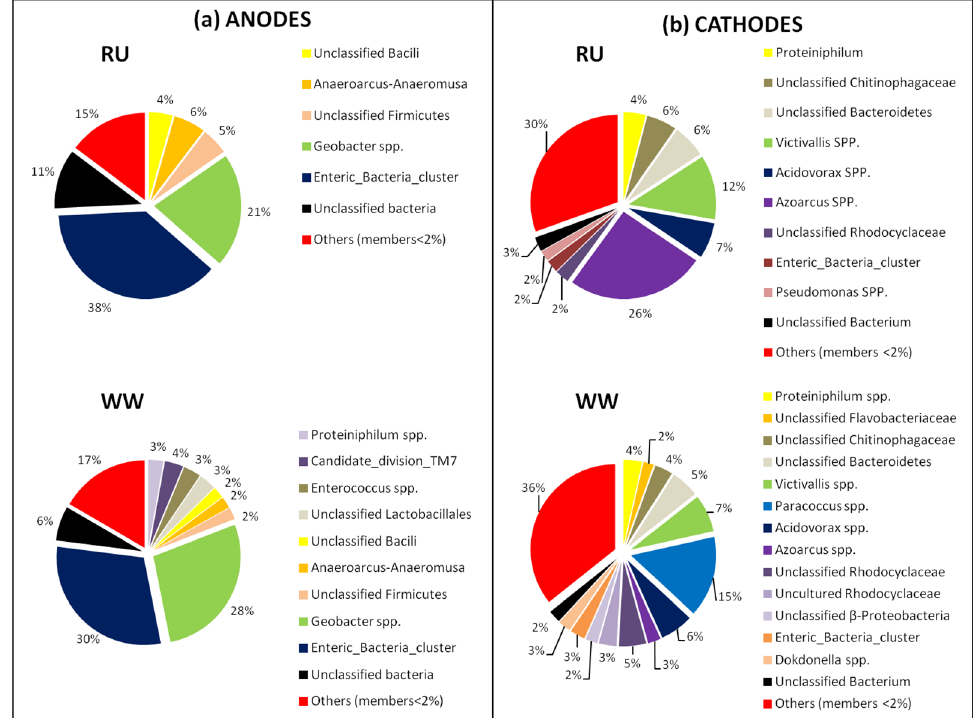
Figure 7. Genus-level community distribution of anodes ( a ) and cathodes ( b ) of rumen (RU) reactors and wastewater (WW).